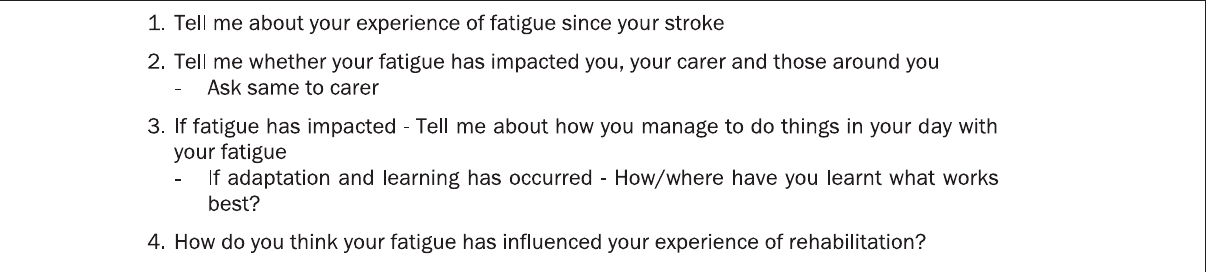
FIGURE 1 | Interview